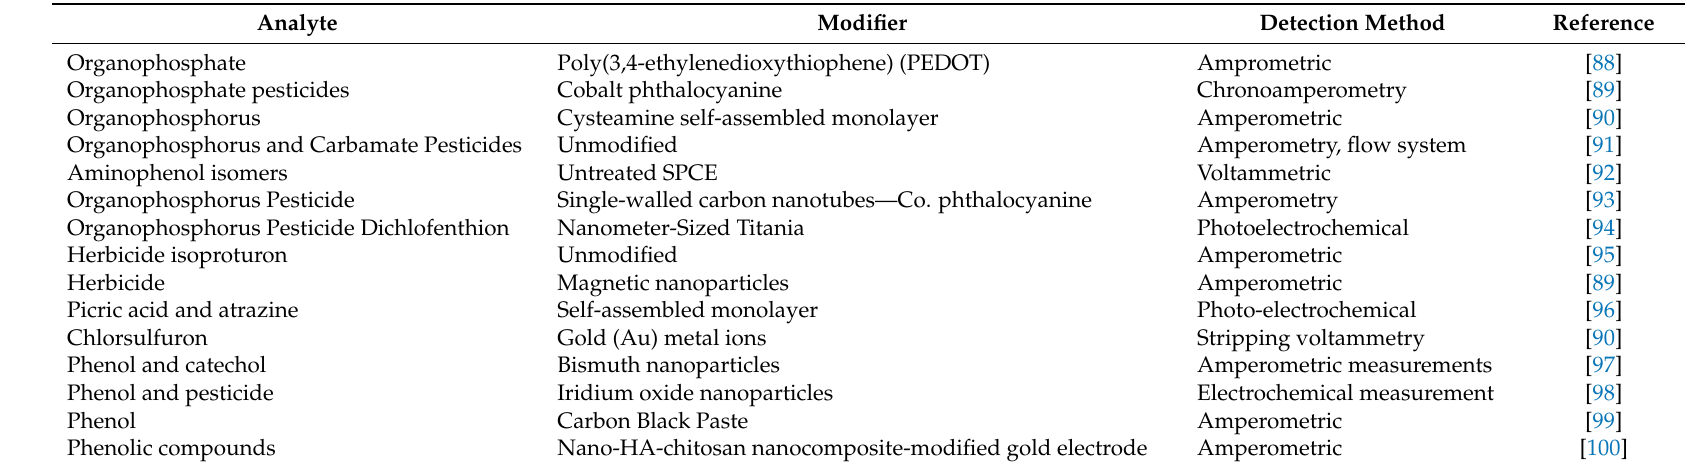
Table 4. Examples of the some of the recently developed screen-printed sensors for organic compounds detection in environmental